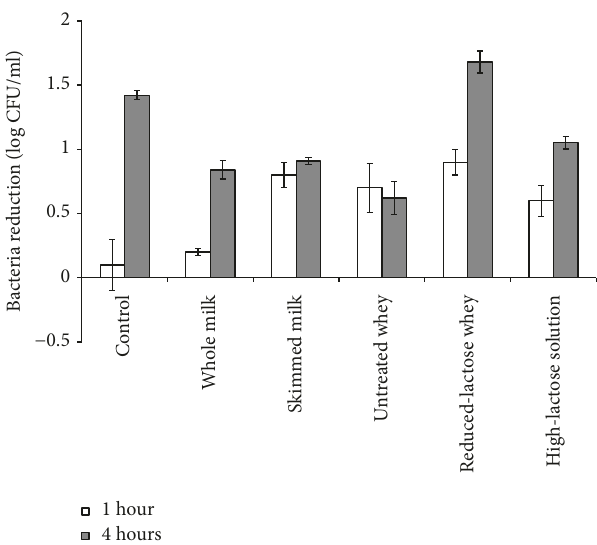
Figure 3: Antibacterial effect of LPOS against E.coli in milk and derivative products. This number was calculated from the initial population of 7.0 ± 0.10 log CFU/ml. The solution containing E. coli and LPOS was incubatedfor 1 and 4 hoursin 30 ∘ C. Valuesare means ± SE (n = 3).